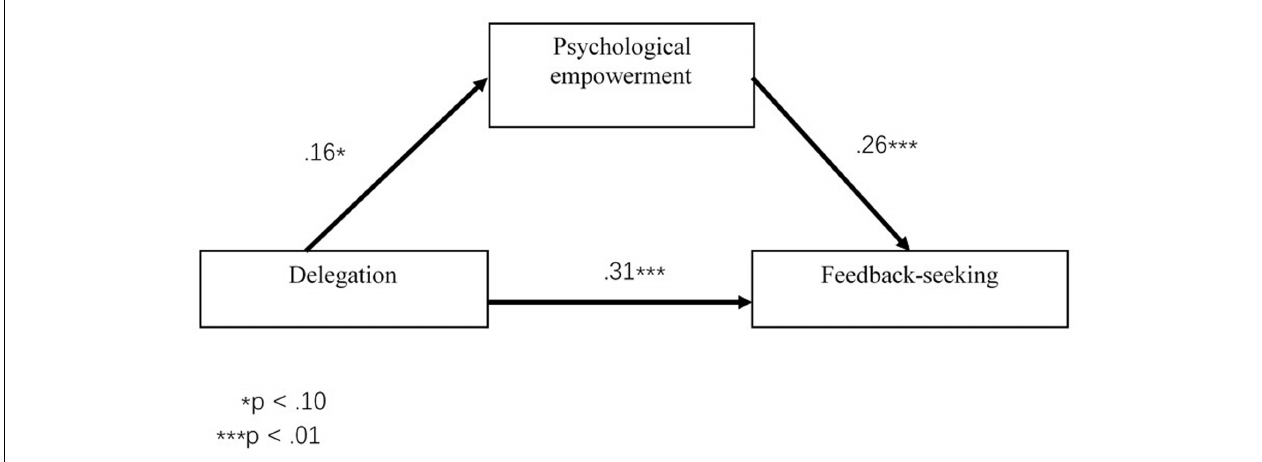
FIGURE 1 | Results of structural equation modeling on the mediating effect of psychological